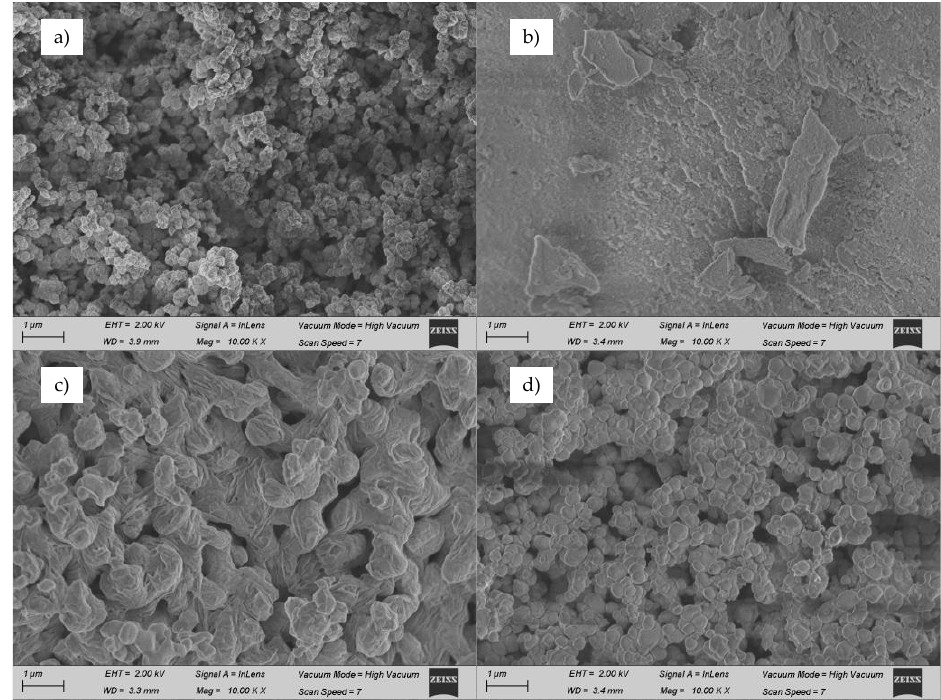
Figure 7. SEM images of initial ( a , b ) and final ( c , d ) Fe 2 O 3 and goethite catalysts, respectively.